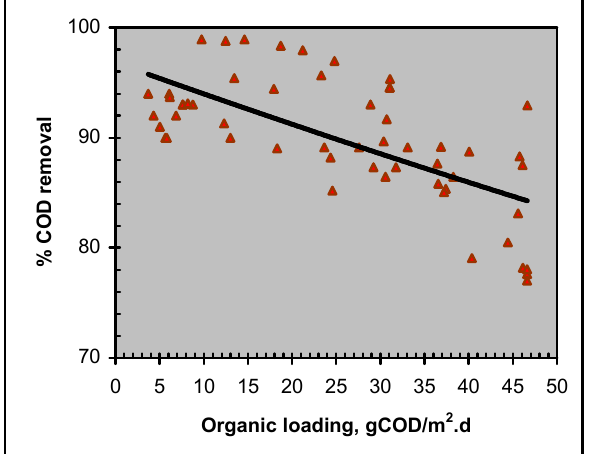
Figure 12: Effect of organic loading on the remaining COD (organic loading up to 100 g COD/m 2 .d).